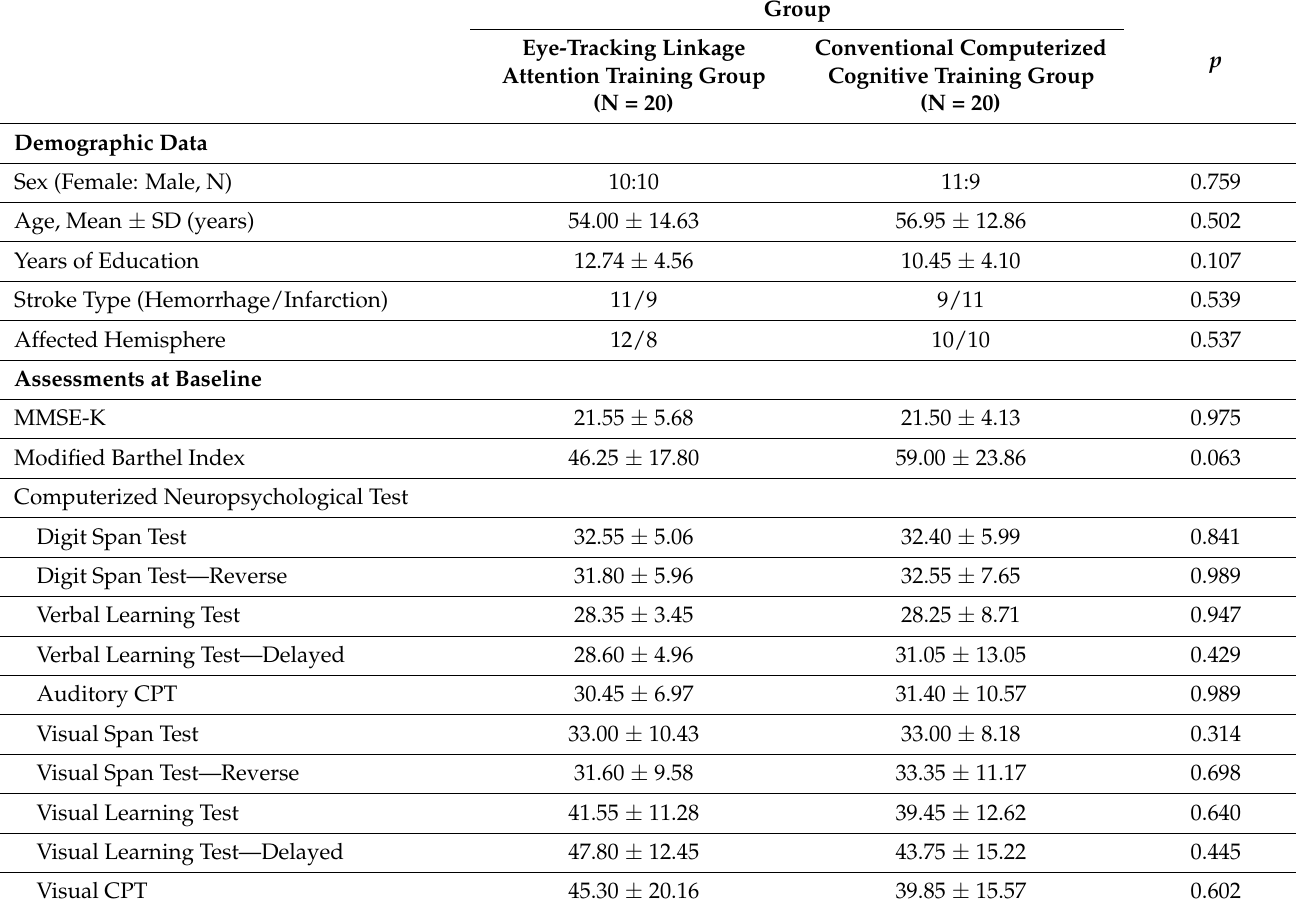
Table 2. Demographic and clinical characteristics of participants with stroke in an eye-tracking linkage attention training group and a conventional computerized cognitive training